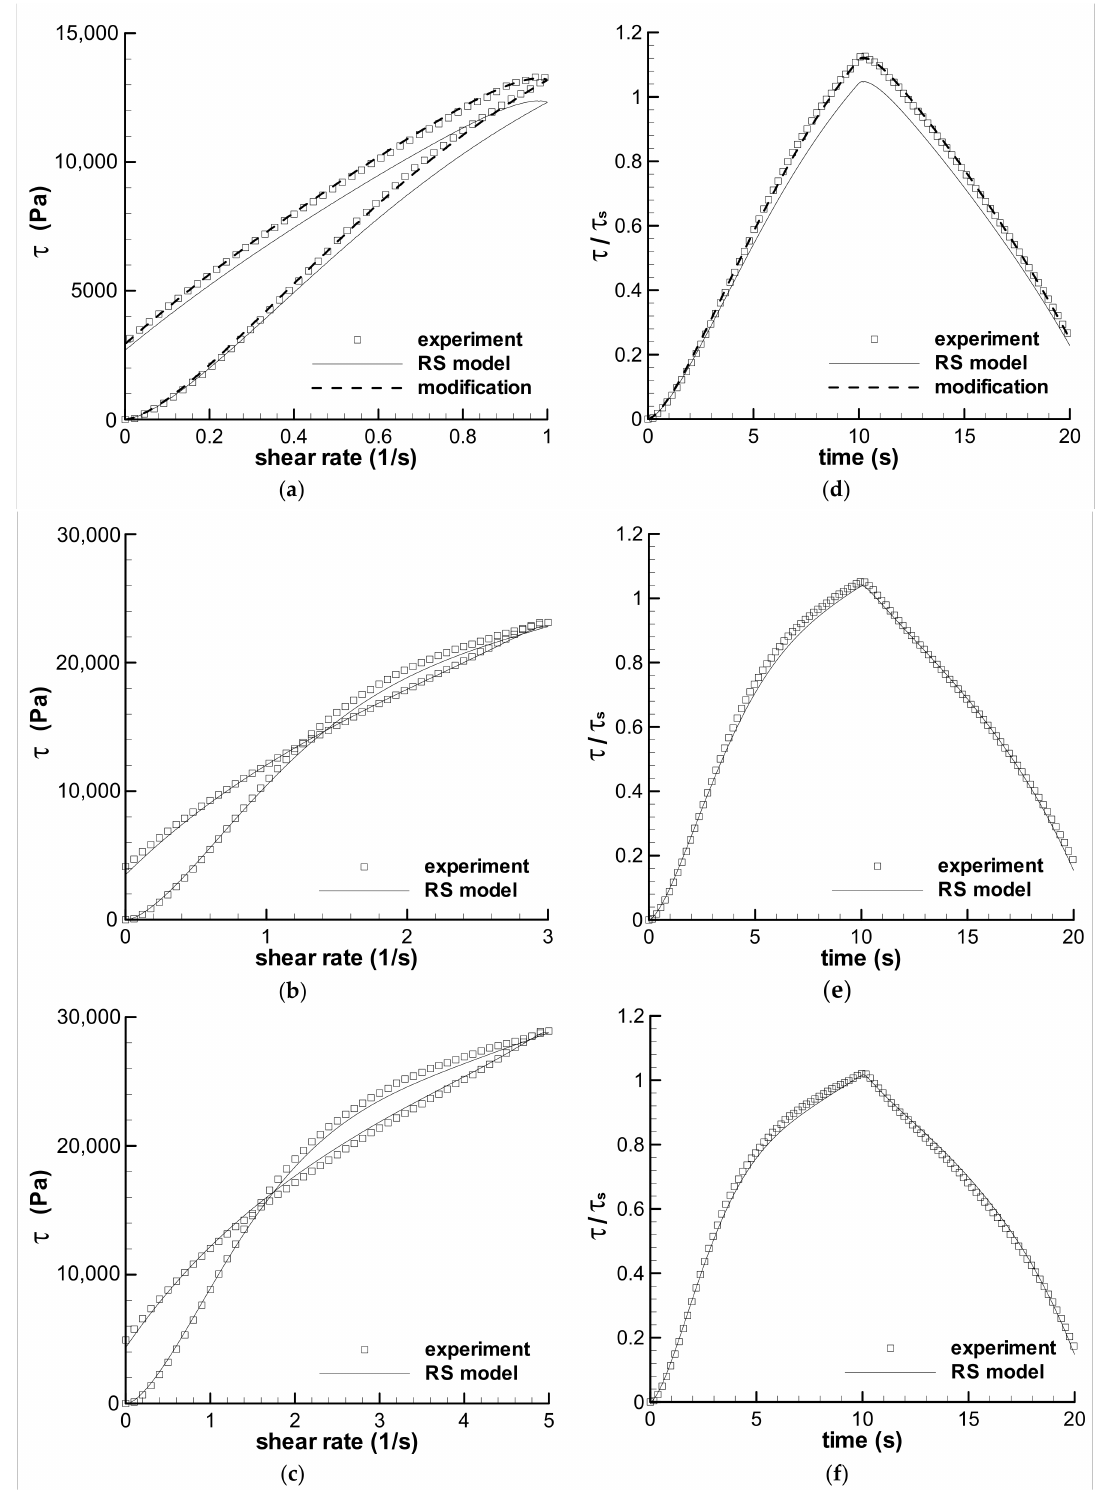
Figure 7. Predictions of the triangular-loop experiments with the same characteristic time t 0 of 10 s. The stress–shear rate curves with the maximum shear rates of 1 s − 1 ( a ), 3 s − 1 ( b ), and 5 s − 1 ( c ) are given. The stress–time curves with maximum shear rates of 1 s − 1 ( d ), 3 s − 1 ( e ), and 5 s − 1 ( f ) are also shown. Symbols are experiments, solid lines are the calculations by the RS model, and dashed lines in ( a , d ) are the calculations by the modified spectrum with f in Table 4. τ s is the steady shear stress calculated by the RS model at the maximum shear